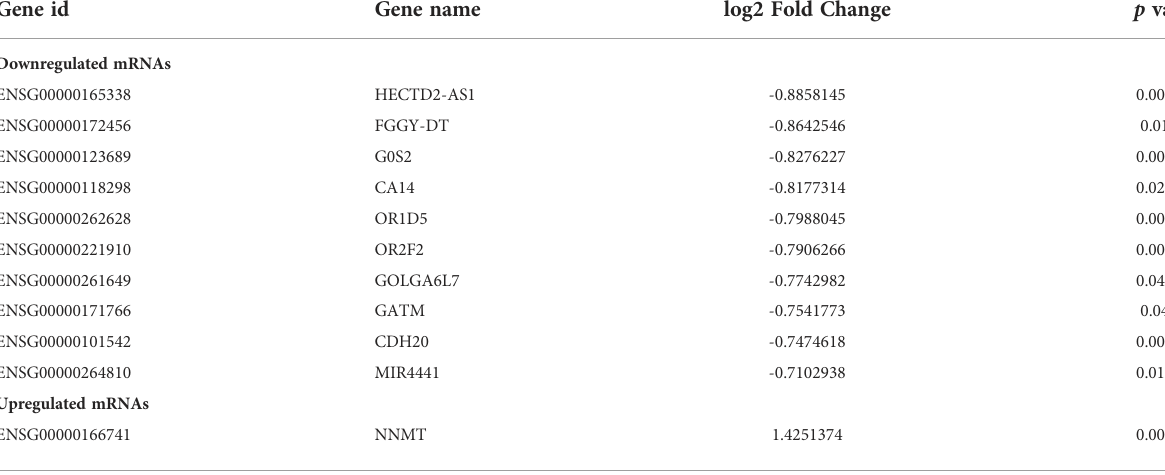
TABLE 1 Top 10 downregulated mRNAs and 10 upregulated mRNAs in cachectic group compared to non-cachectic